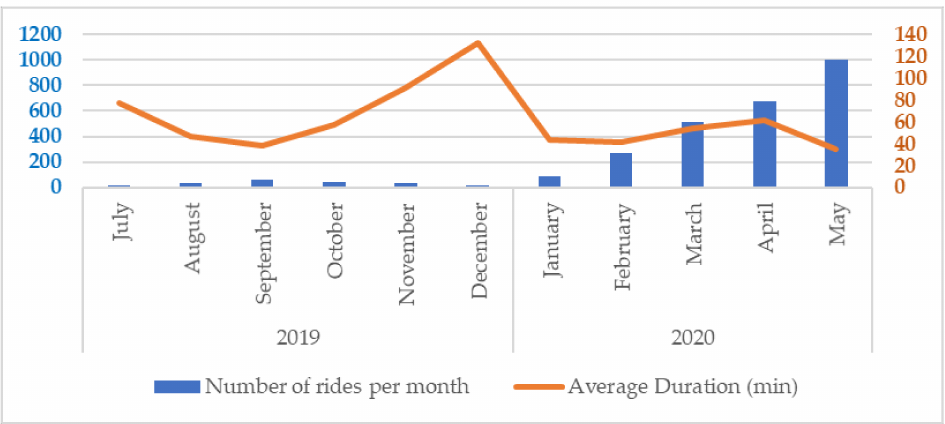
Figure 4. Evolution of Igoumenitsa‘s bike-sharing system—number of rides per month and average duration.